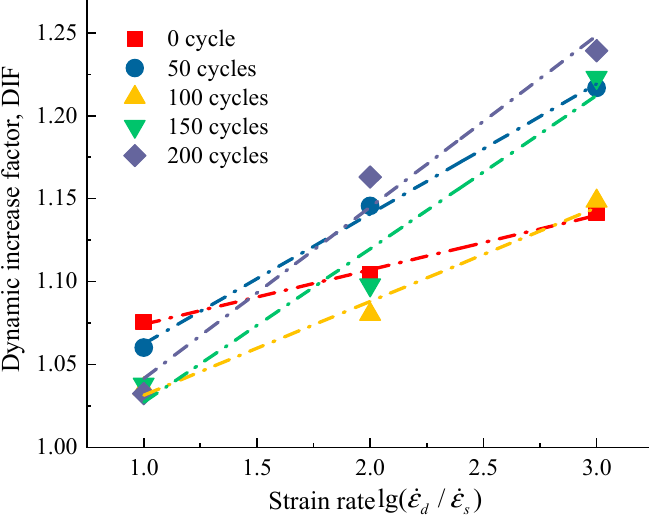
Figure 13. Variation of dynamic increase factor (DIF) and strain rate. Table 2. Regress equations of the relationship between strain rate and DIF under different freeze–thaw cycles. Freeze–Thaw Cycles/N